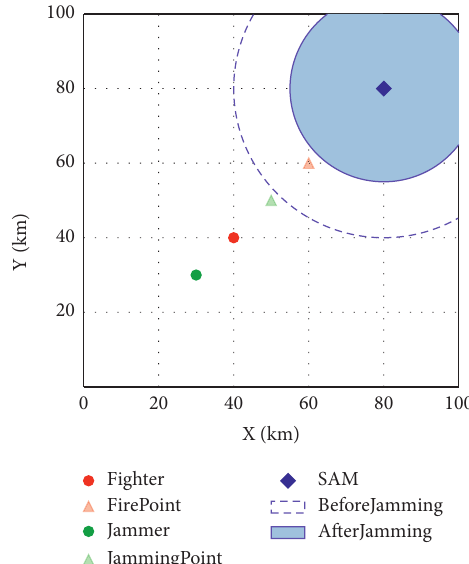
Figure 7: SEAD environment in present work.